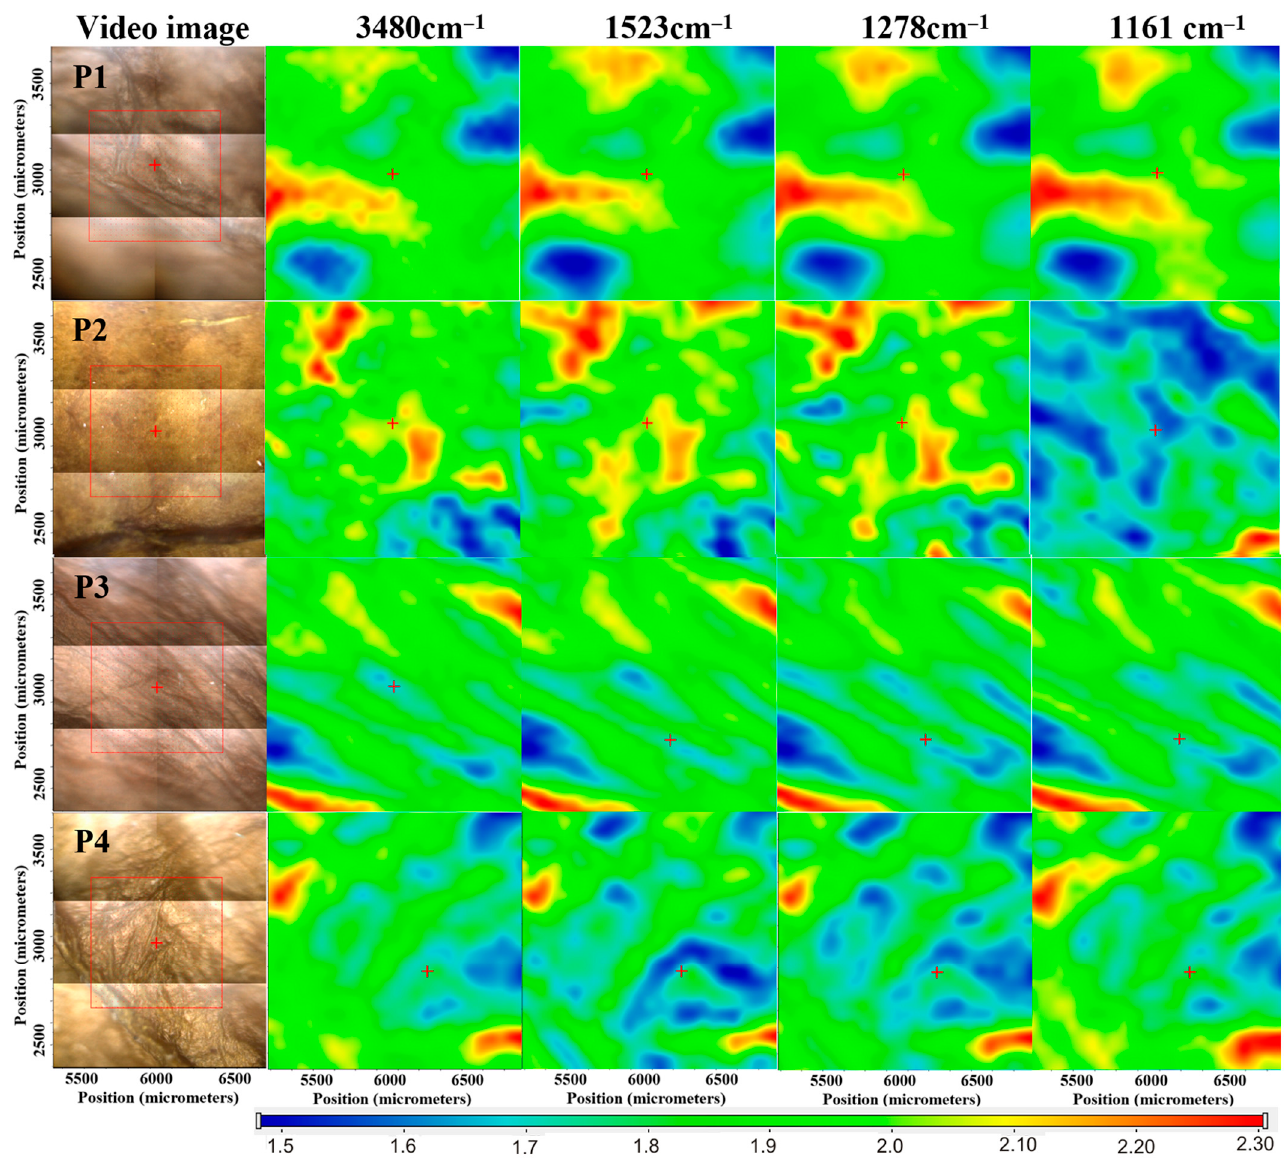
Figure 3. FTIR map for P1–P4 samples.